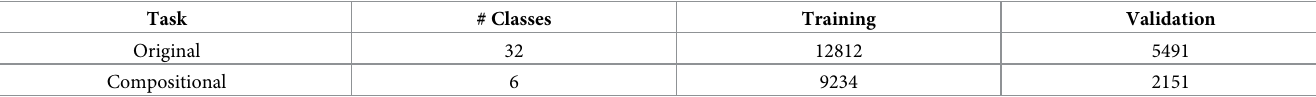
Table 4. Statistics of original action recognition and compositional action recognition on IKEA ASM. Task